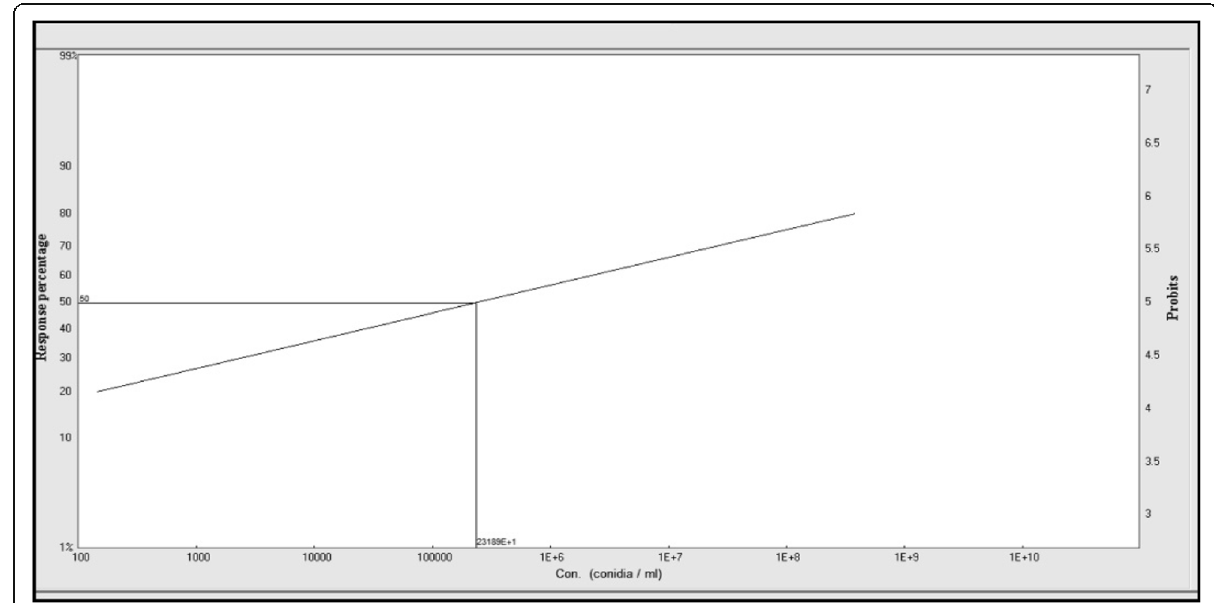
Fig. 2 Concentration-mortality probit lines of Paecilomyces lilacinus against the second-instar larvae of Galleria mellonella